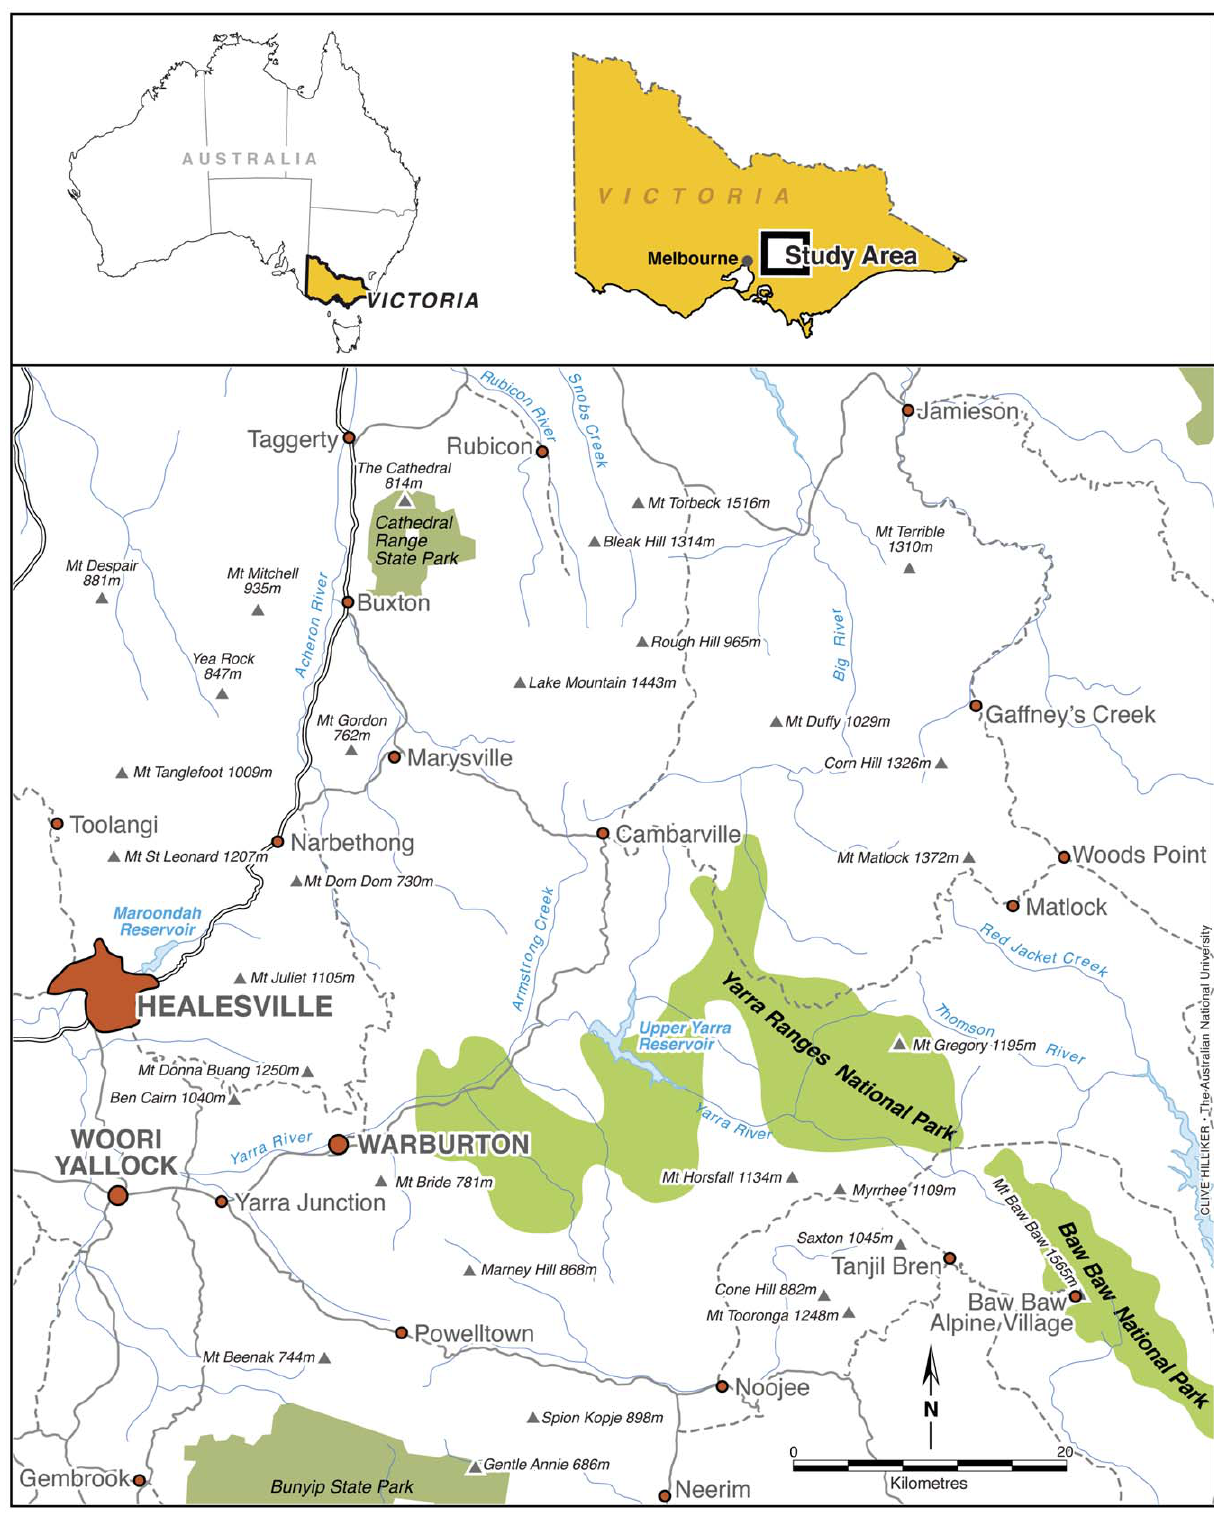
Figure 1. The study area in the Central Highlands of Victoria, south-eastern Australia.